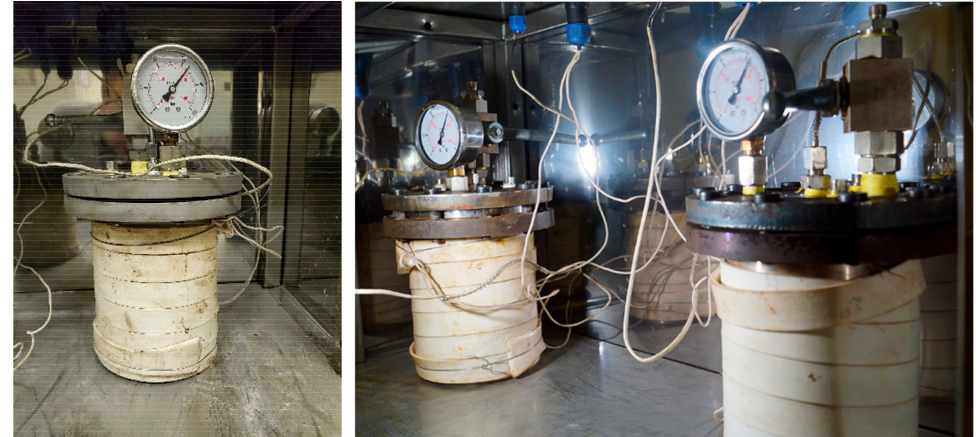
Figure 2. Autoclaves used for